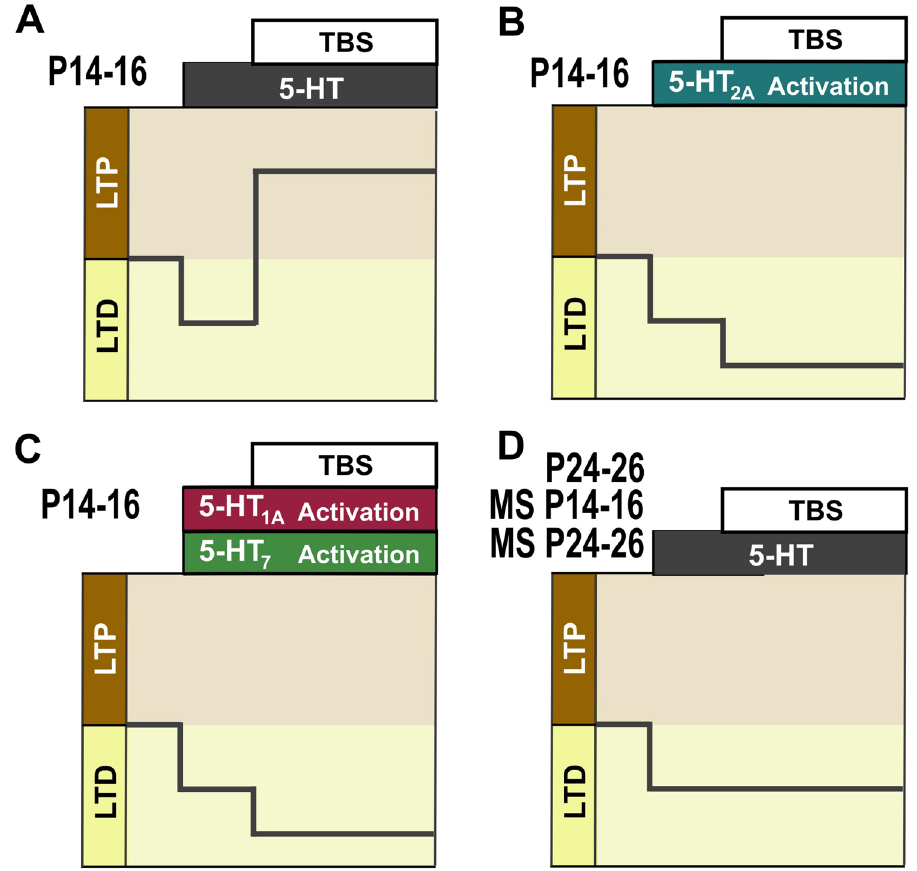
expression, while the synergistic recruitment of multiple 5-HT receptor types activation allows the occurrence of LTP. The metaplastic interaction between TBS and 5-HT is age dependent and absent in the P24-26 period. ( A ) The expression of LTP requires the interaction between TBS and 5-HT. ( B ) TBS induction coupled with activation of